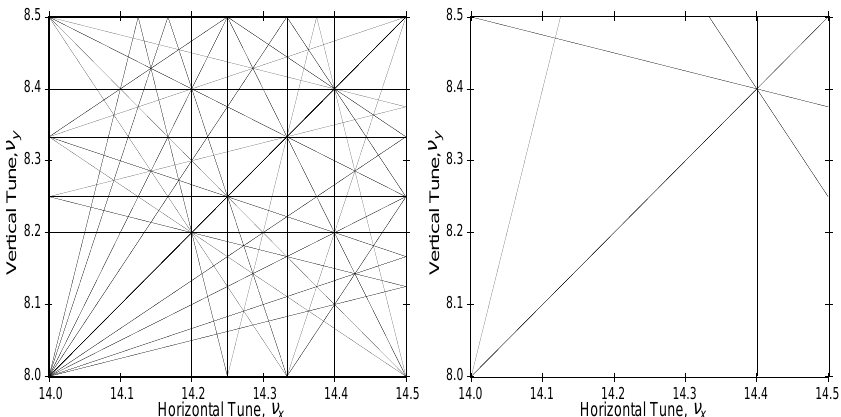
FIG. 2. Resonance diagram: All betatron resonances up to 5th order (left); all “allowed” resonances up to 5th order with 12-fold periodicity (right).